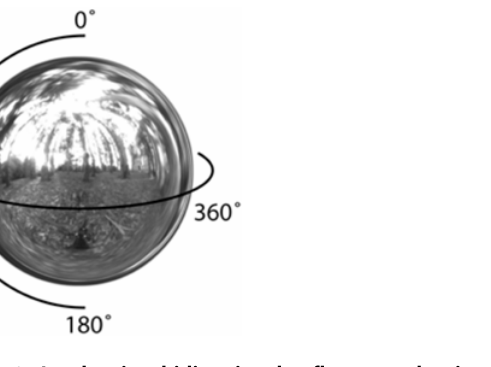
Figure 2. Lambertian bidirectional reflectance density func- tion. The light field recorded at a point in a forest scene. The environment map for this illustration was obtained from http://www.